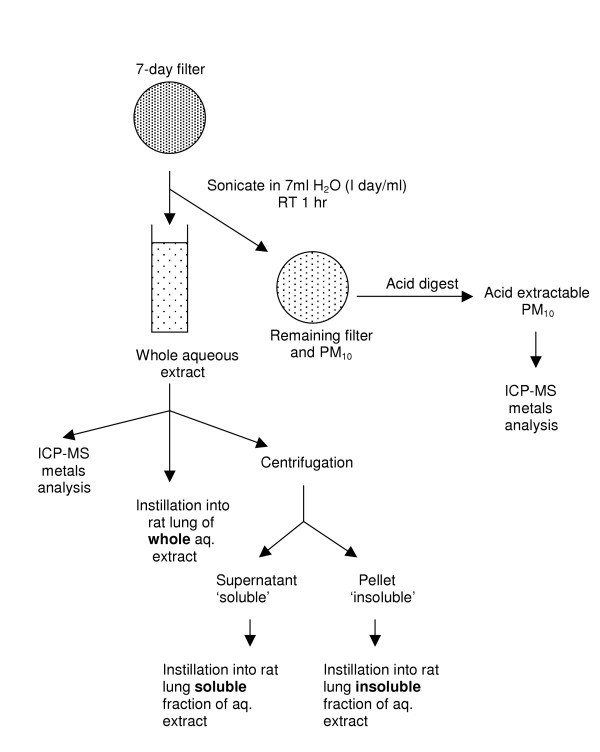
Diagram detailing the methods used to prepare samples to examine composition and toxicity of Redcar PM10.